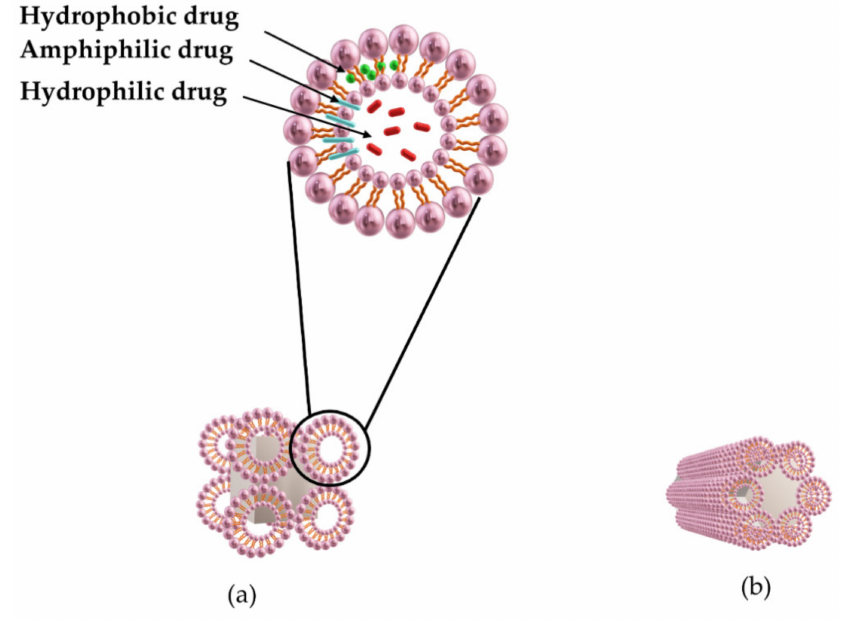
Figure 7. Schematic illustration of ( a ) cubosome; ( b )